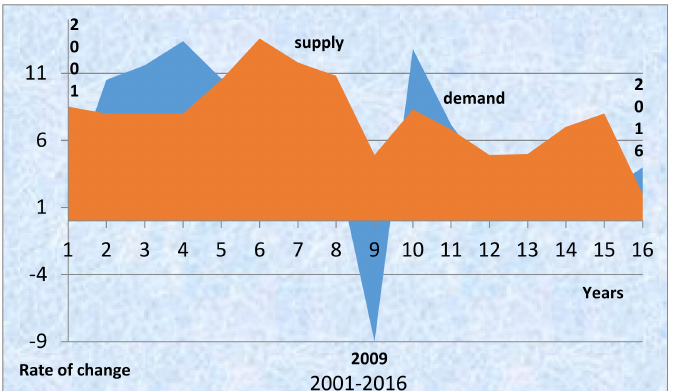
Figure 5. Demand and supply growth rates, 2001–2016. Source: Author and excel on numbers from UNCTAD (2016); 2016 figures are